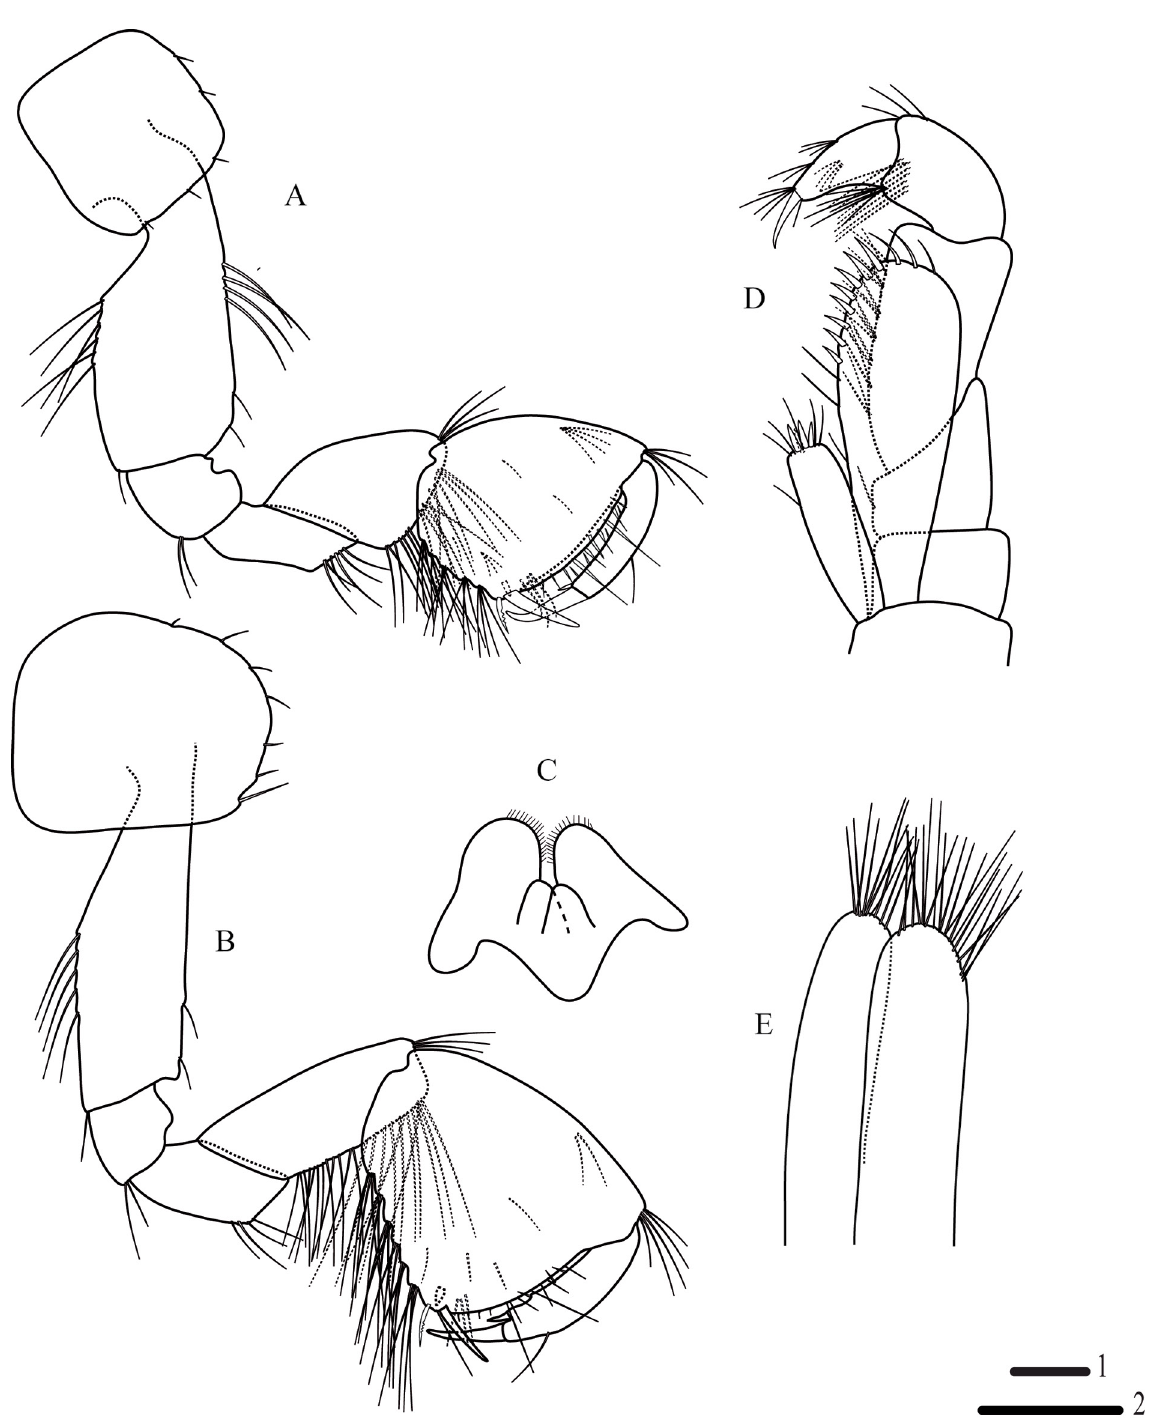
Fig. 4. Niphargus urmiensis sp. nov., holotype, ♂, 8 mm (ZCRU Amph.1071). A . Gnathopod I. B . Gnathopod II. C . Labium. D . Maxilliped. E . Maxilla II. Scale bars: 1 = 0.5 mm (C–E); 2 = 1 mm